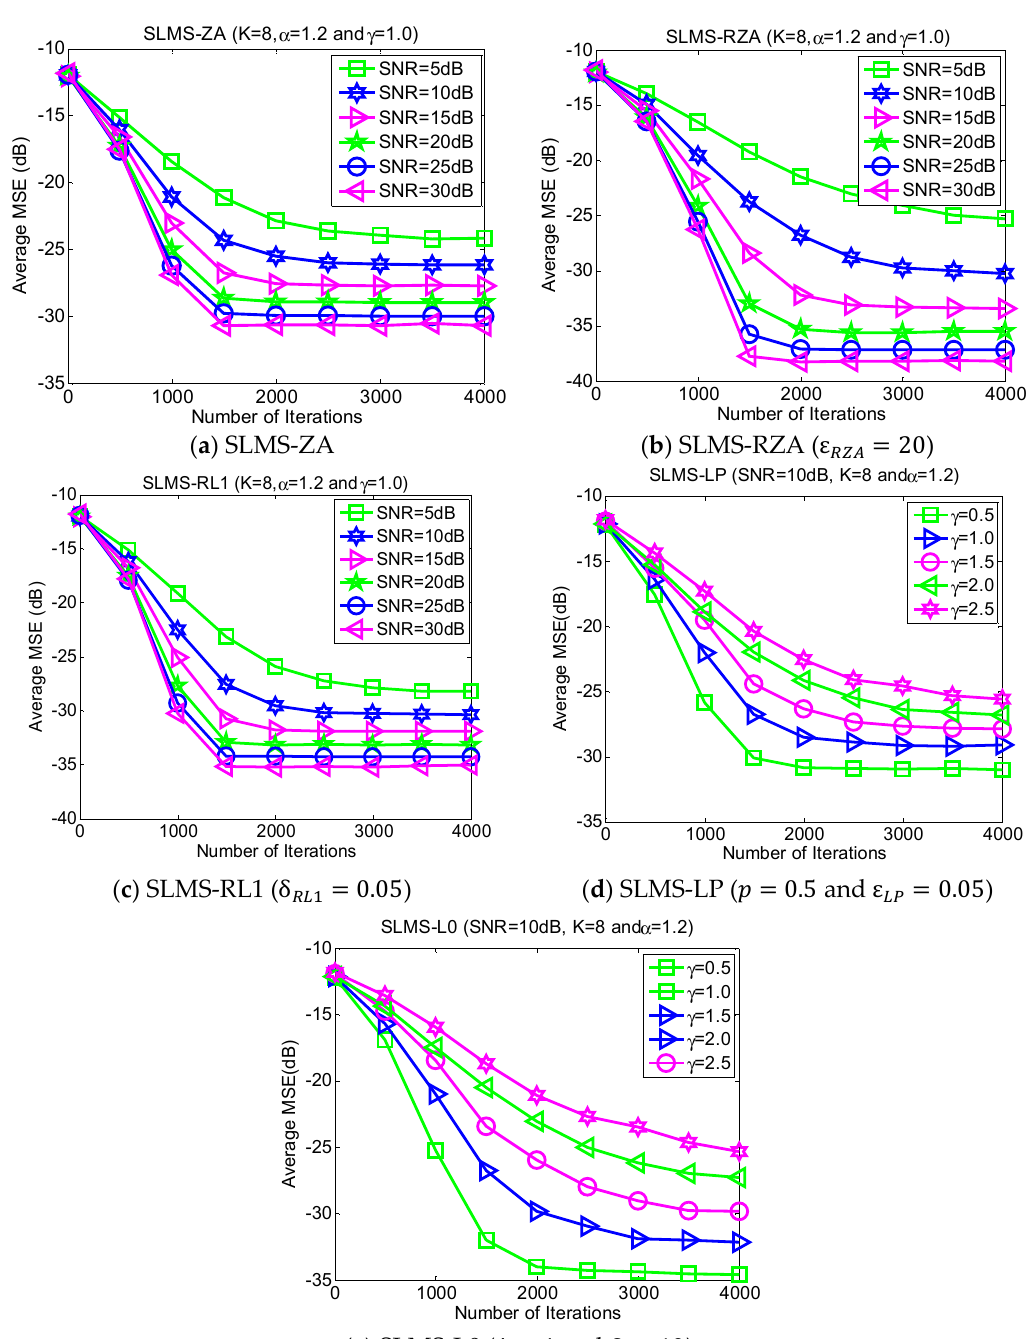
Figure 6. Monte Carlo based MSE curves averaging over 1000 runs with respect to different SNR regimes SNR ∈ { 5 dB, 10 dB, 15 dB,20 dB,25 dB,30 dB } in scenarios of characteristic exponent α = 1.2, dispersive parameter γ = 1.0, channel length N = 128, and channel sparsity K =